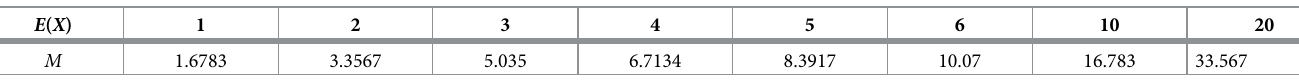
Table 10. Optimal value of M in the exponential case.